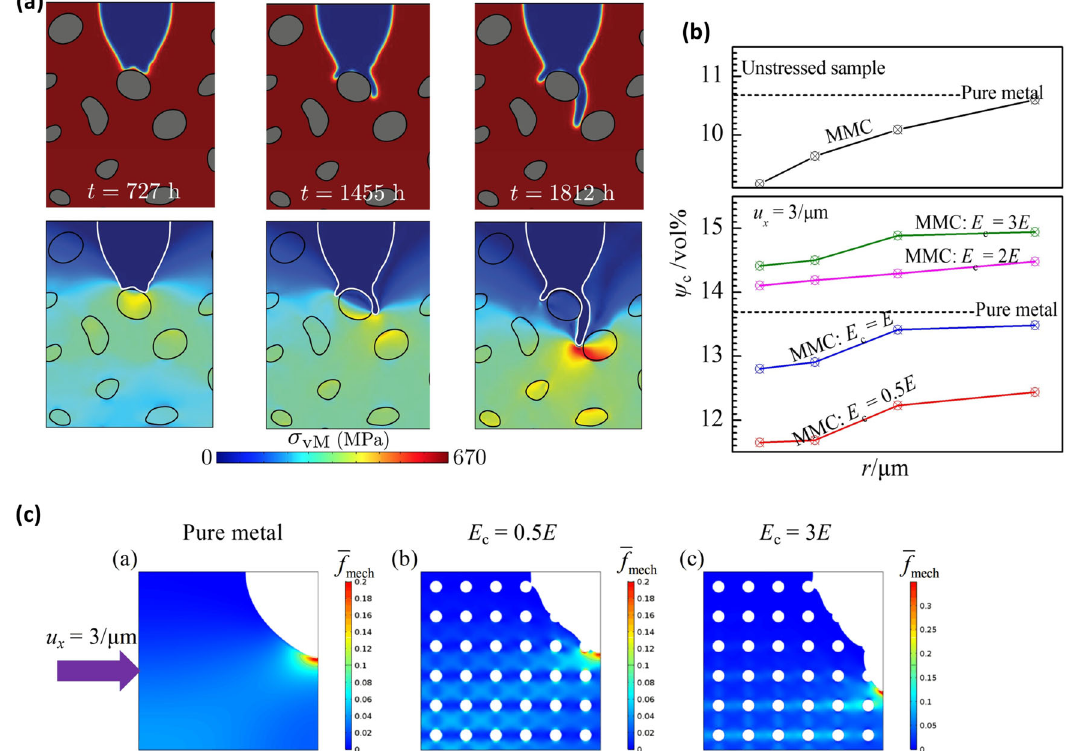
Fig. 7 Ceramic-particle reinforced steel. a Evolution of a pit in ceramic-particle reinforced steel in the presence of mechanical loading 98 . b , c The corrosion losses for ceramic particles with different Young ’ s modulus values ( E c ) 100 . a is reproduced with permission from ref. 98 , published by Elsevier in 2017. b , c are reproduced with permission from ref. 100 , published by Elsevier in